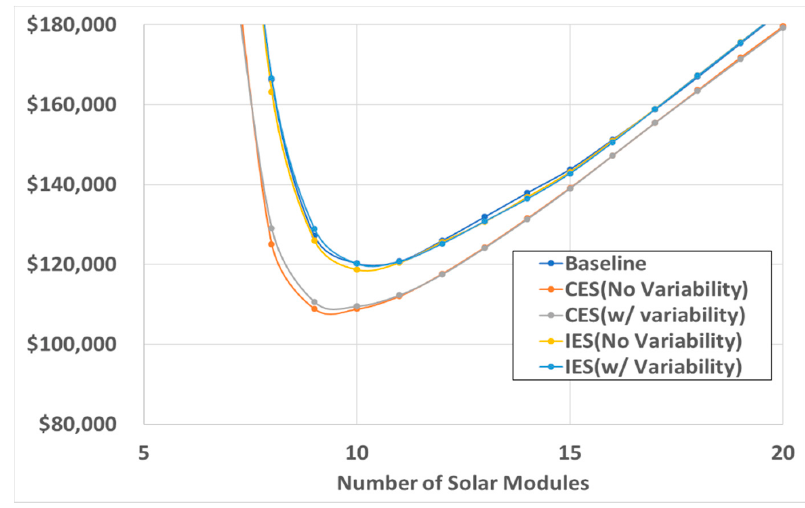
Figure 10. Changing load offset given June, 10% initial charge, five systems, Indianapolis, 0.1% LPSP.